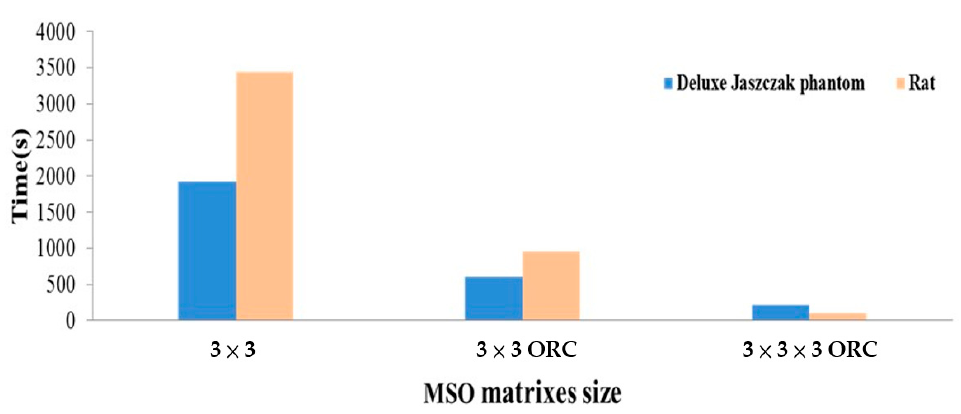
Figure 8. Evaluation of the computational time for MSO-processed FBP images of the Deluxe Jaszczak phantom and rats. The results revealed a shorter computational time by ORC.